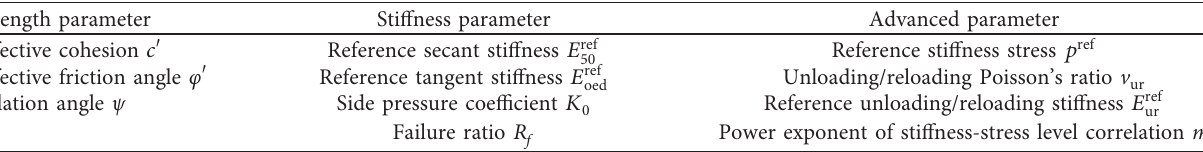
Figure 1: (a) Yield surface in the P-Q plane and (b) stress-strain curves of the HS Table 2: Main parameters of the HS model [29, 30].